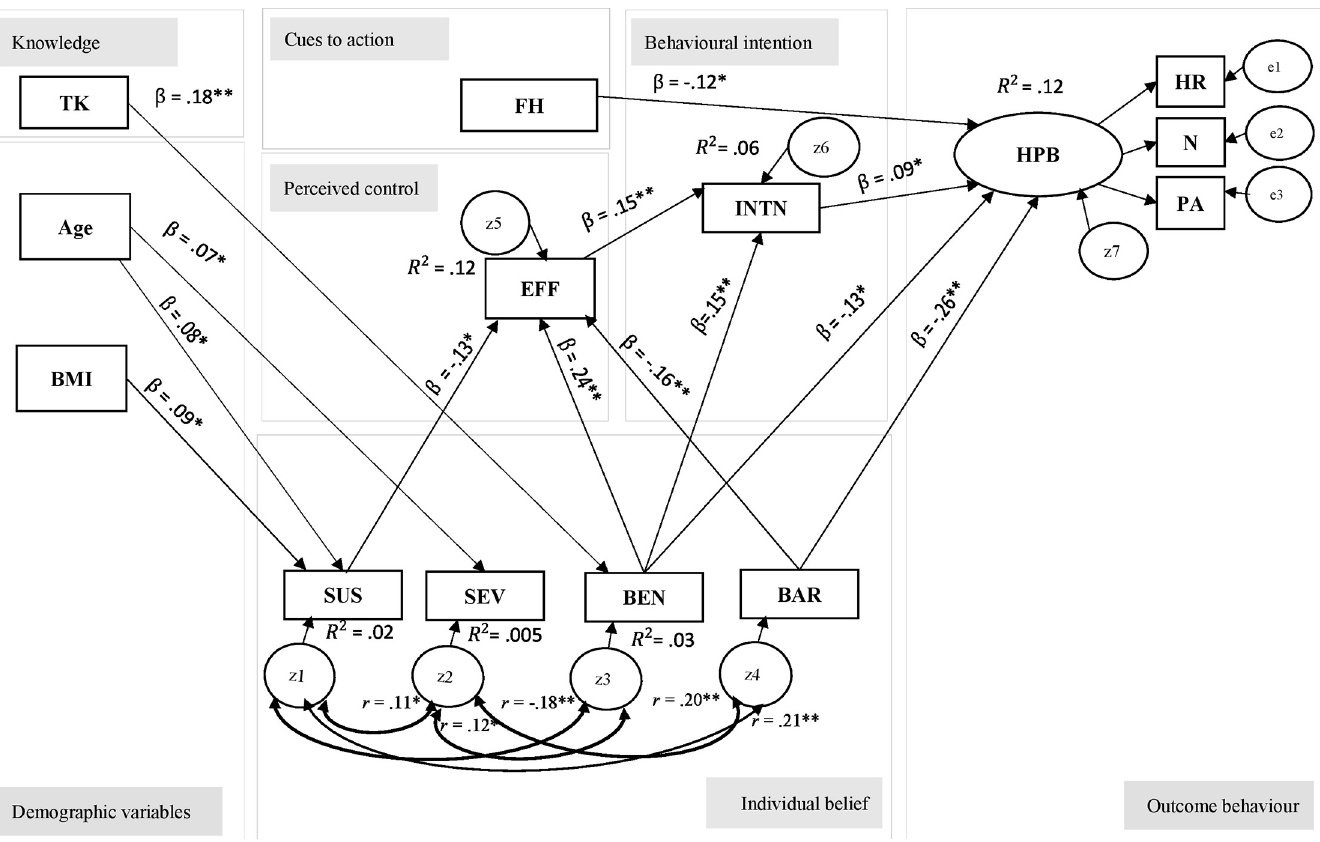
Fig 2. Hypothesised structural model: Final model/model 3. � P � .05, �� P � .001, z1-z7 and e1-e3 = disturbances (error in measurement), r = correlation coefficient, TK = total knowledge, BMI = body mass index, SUS = Susceptibility, SEV = Severity, BEN = Benefits, BAR = Barriers, EFF Self-efficacy, INTN = screening intention, HPB = health-promoting behaviours, FH = family history of CVD, R 2 = final coefficient of determination, H = hypothesis.